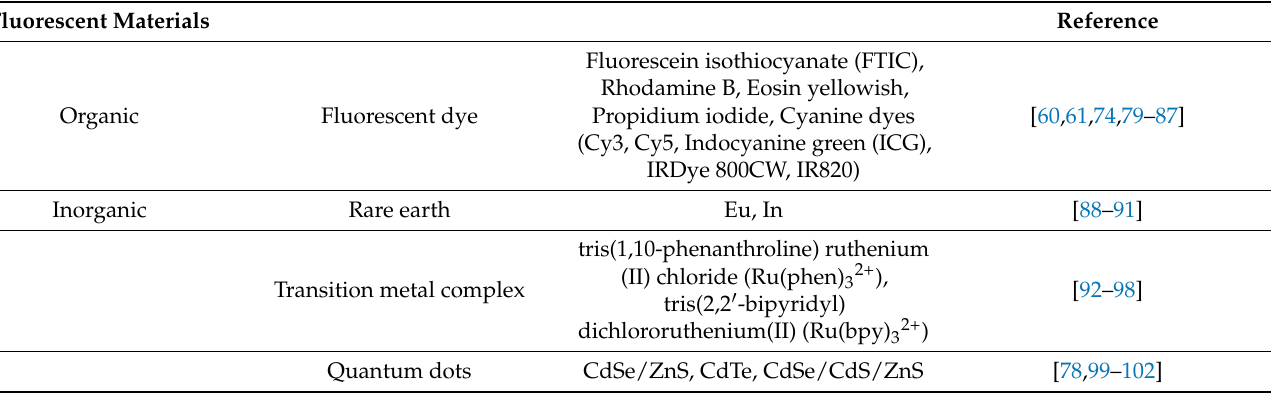
Table 1. Category of fluorescent materials for silica